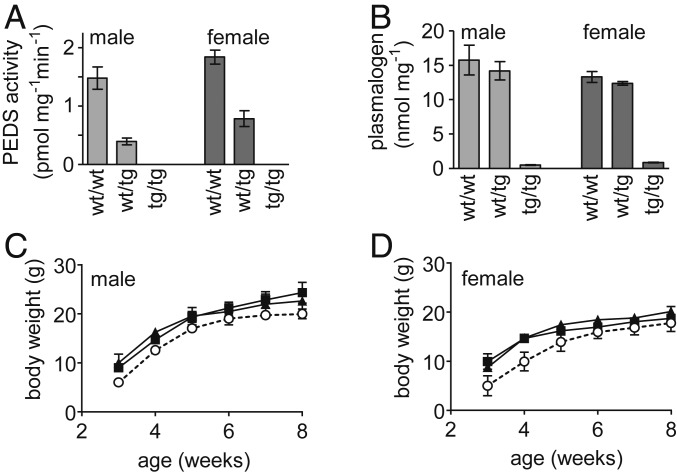
PEDS activities, plasmalogen levels, and body weight in mice depending on the Tmem189 gene locus. Tmem189tm1a(KOMP)Wtsi mice were housed under standard conditions and weighed weekly, and kidneys were collected at 8 wk for PEDS activity and plasmalogen measurements as described in Materials and Methods. The tg was a knockout-first allele leading to an inactive truncated TMEM189 protein by artificially splicing a LacZ reporter downstream of exon 2 (28). (A) PEDS activity in kidney samples. (B) Plasmalogen levels in kidney samples. (C) Body weight in male animals. (D) Body weight in female animals. Open circles, dashed line: homozygous tg animals (tg/tg); solid squares, solid line: heterozygous animals (wt/tg); solid triangles, solid line: WT animals (wt/wt). Data are mean ± SEM for three animals each.